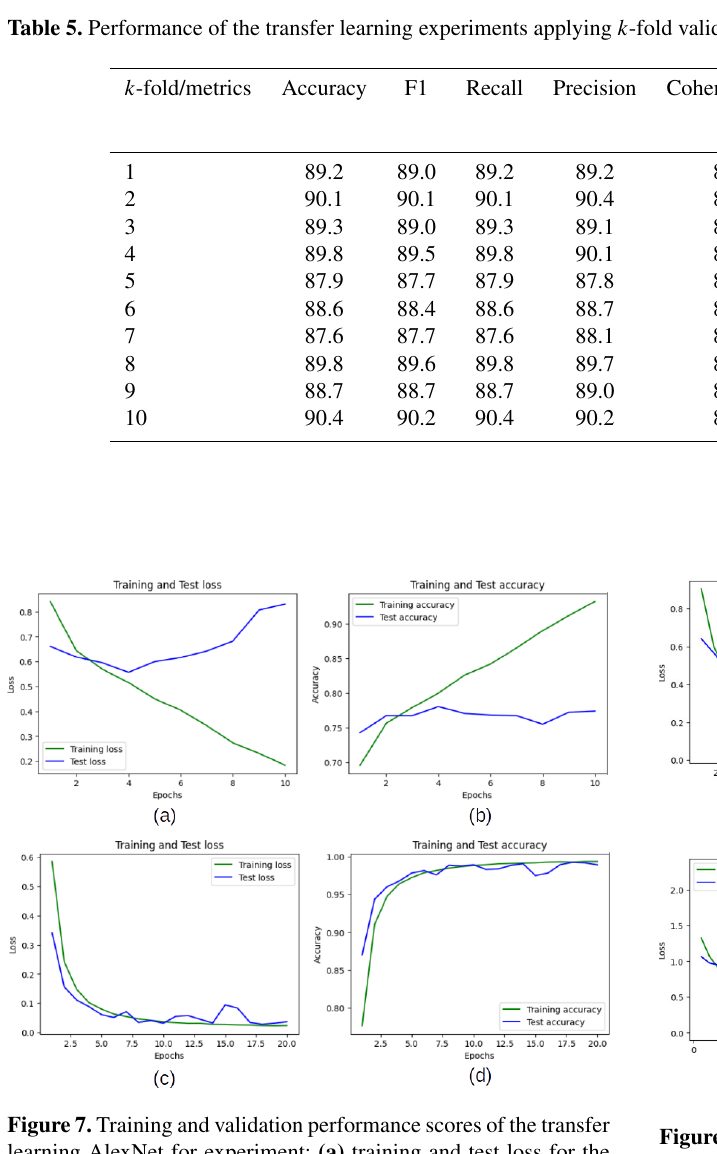
Figure 8. Training and validation performance scores of the trans- fer learning AlexNet for experiment: (a) training and test loss